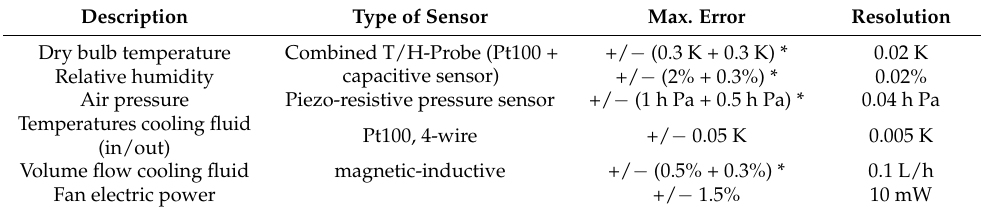
Table 2. Description and specifications of the installed